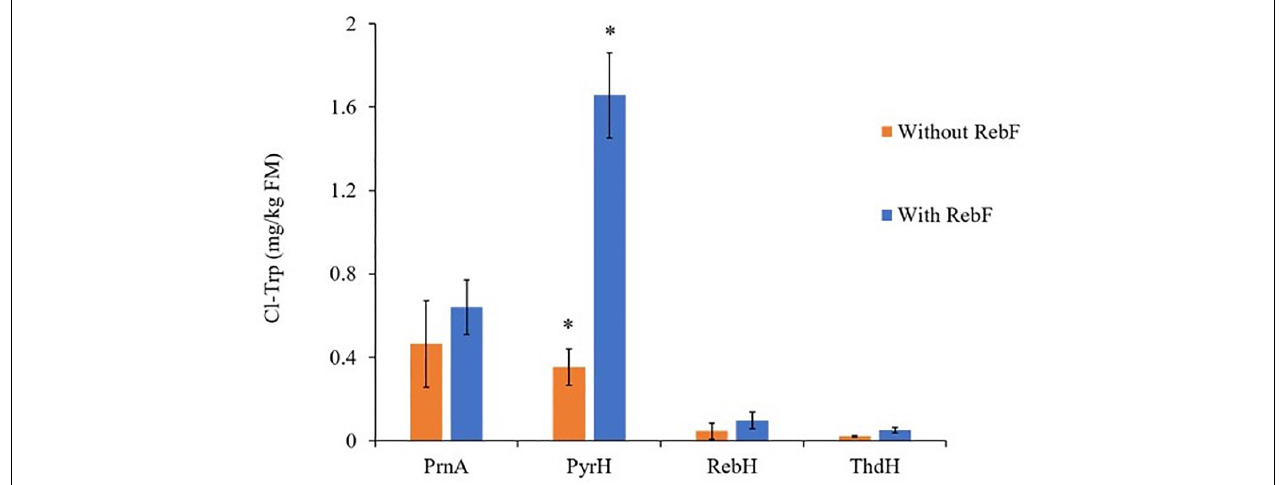
FIGURE 4 | Cl-Trp production above background levels by N. benthamiana leaves following infiltration of a flavin-dependent halogenase with and without the partner reductase, RebF. In all cases bars show mean ± SEM, n = 4. * indicates significant difference following analysis by a two-sample, two-tailed Welch’s t -test in RStudio, p ≤ 0.005. A Shapiro–Wilks test was used to verify that the Cl-Trp production by each replicate leaf followed a normal distribution. The outcome of the t -test cannot be relied upon for the comparison between RebH +/– RebF, as the Cl-Trp replicate yields for RebH – RebF are not normally distributed.